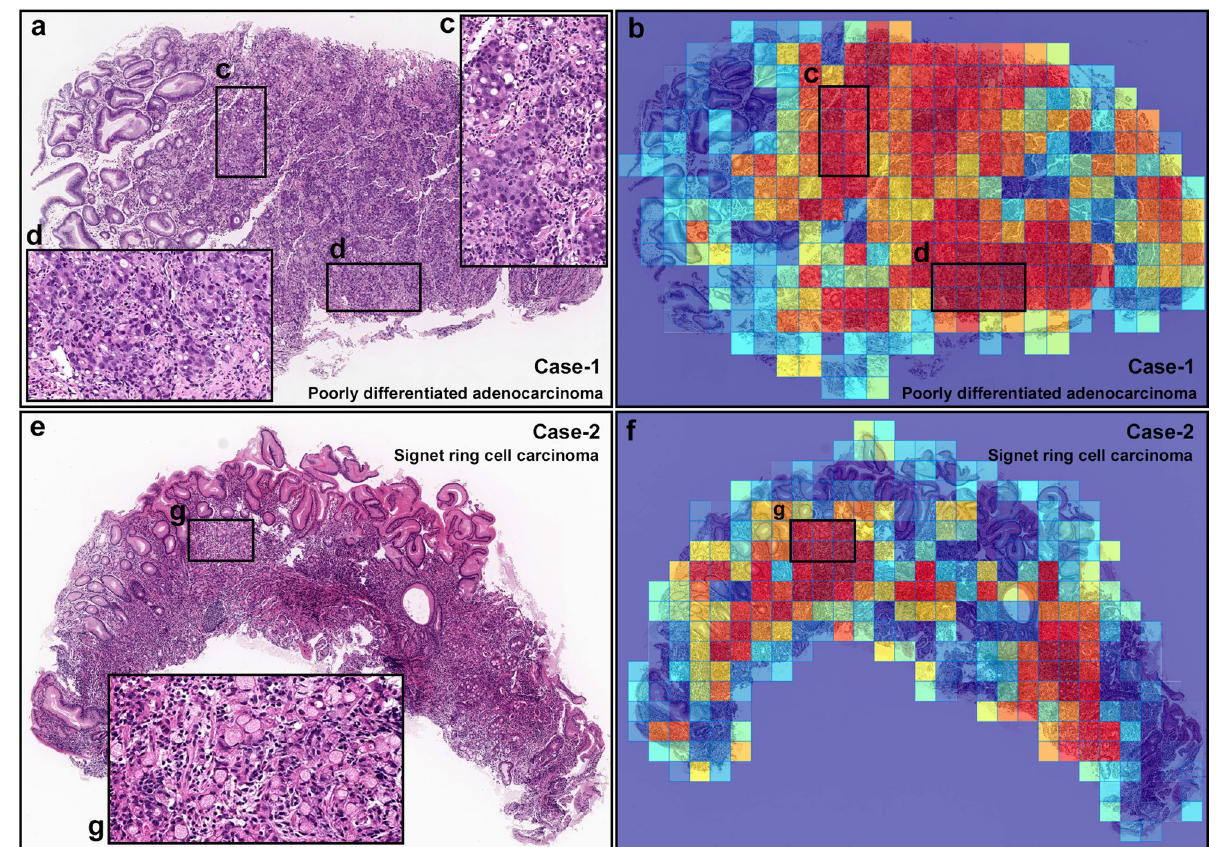
Figure 3. Representative true positive diffuse-type gastric ADC cases from endoscopic biopsy test set. Case-1 ( a – d ) is a poorly-differentiated ADC and Case-2 ( e – g ) is a SRCC. Heatmap images ( b and f ) show true positive predictions of poorly-differentiated ADC ( b ) and SRCC ( f ) cells and they correspond respectively to ( a ) and ( e ) H&E histopathology. The high magnification images ( c , d , and g ) show representative poorly-differentiated ADC ( c and d ) and SRCC ( g ) cellular morphology. Model applied at × 20, where the 224 × 224px heatmap 2 square represents 112 × 112 µ m